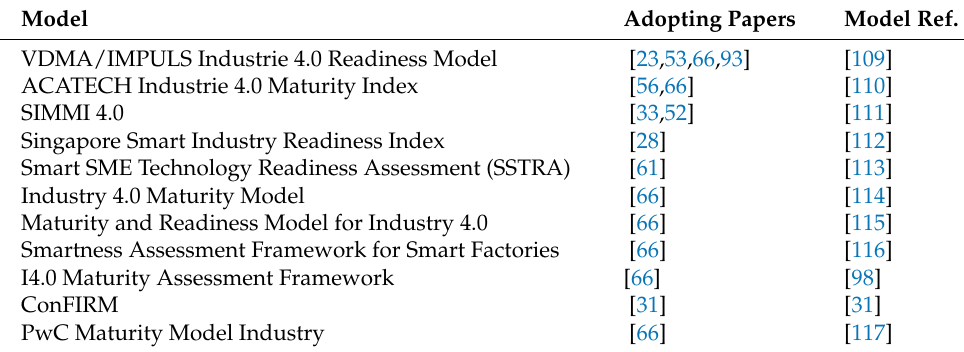
Table 7. Established